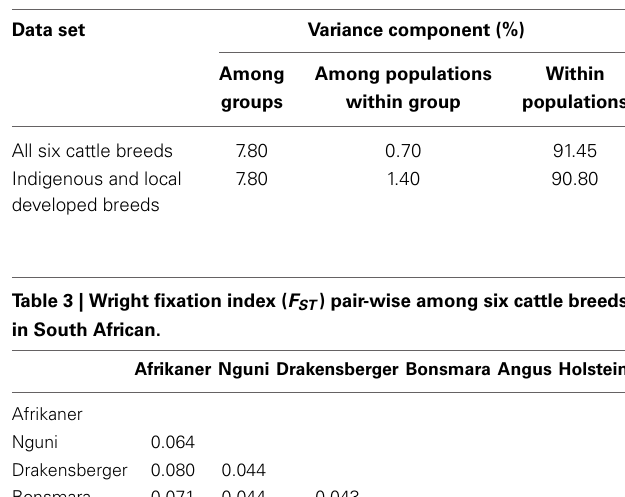
Table 2 | Analysis of Molecular Variance among six cattle breeds in South Africa.